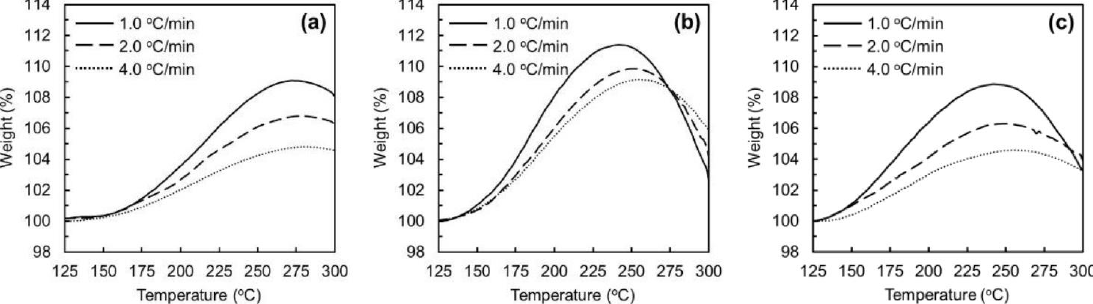
Figure 3. Thermo-gravimetric analysis (TGA) profiles of the oxidation–stabilization of mesophase pitch fibers with different applied pressures: ( a ) AR mesophase pitch fiber (ARMP-F)14 and ( b ) ARMP-F10.